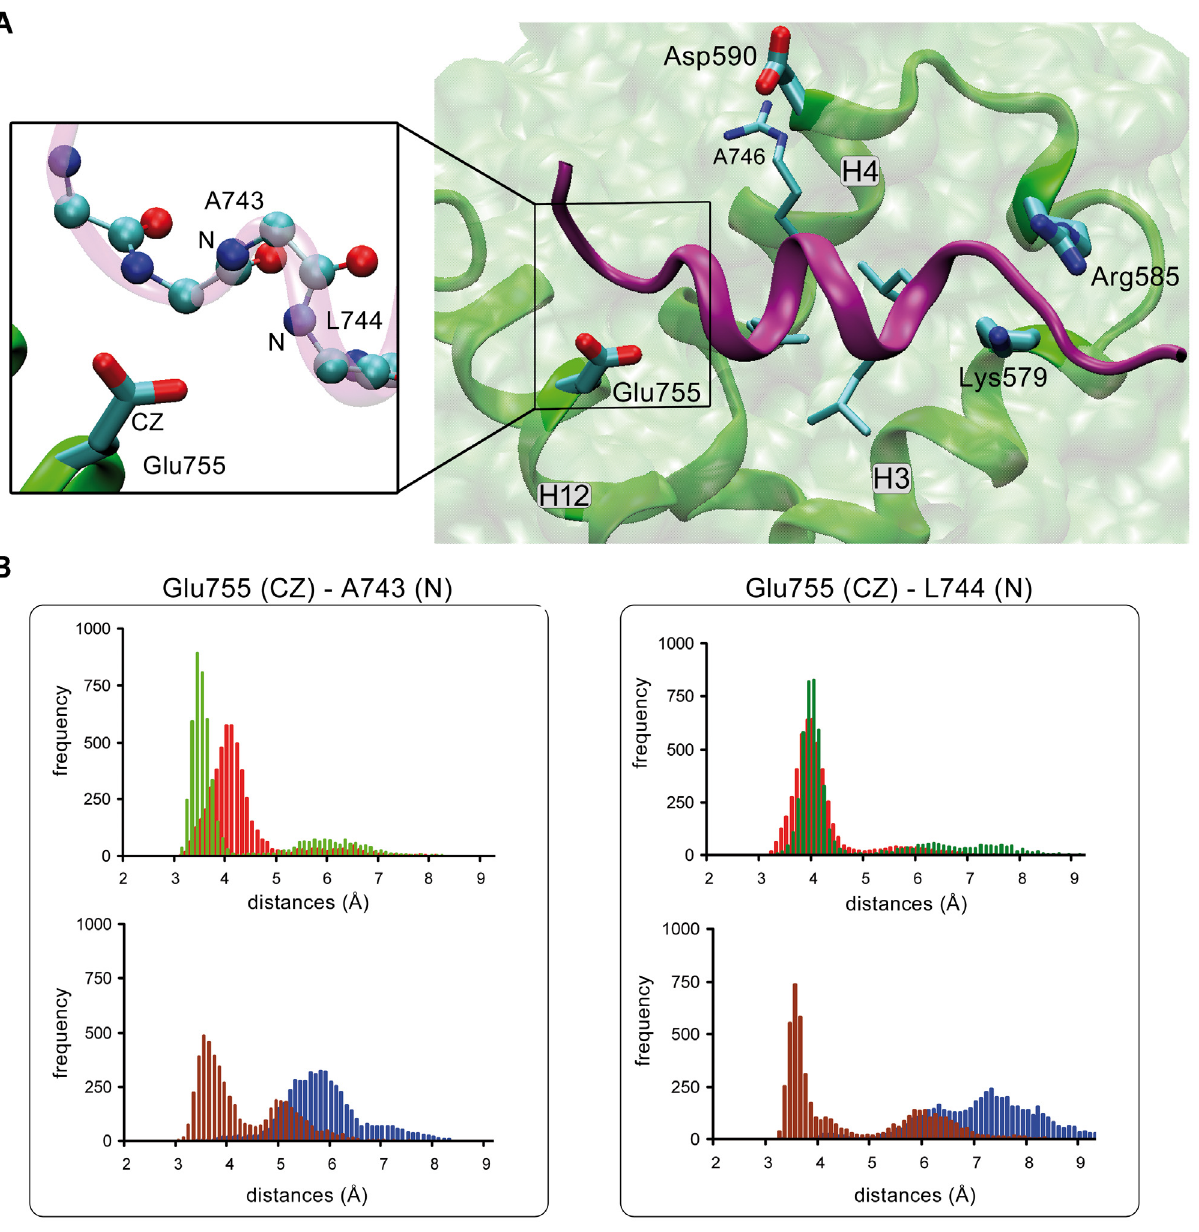
Figure 6. MD simulation of GR LBD-ligand/TIF2 complexes. A . AF-2 domain (green) is formed by helices H3, H4 and H12. GR LBD residues from Glu755, Lys579 and Arg585 have electrostatic interactions with the TIF2 coactivator backbone (violet). Asp590 residue has electrostatic interactions with the lateral side chain of TIF2 R746 residue. The figure also shows TIF2 leucines interacting hydrophobically with the GR LBD. This image is derived from the pdb:1 m2z crystal structure. B . Histograms of the distances between the Glu755 CZ carbon atom of GRLBD and A743 N atom or L744 N atom of TIF2 peptide. GR LBD-Dex/TIF2 (red), GR LBD-21OH-6,19OP/TIF2 (blue), GR LBD-21HS-6,19OP/TIF2 (green), GR LBD-RU486/ TIF2